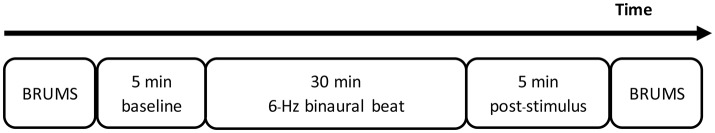
Experimental timeline.